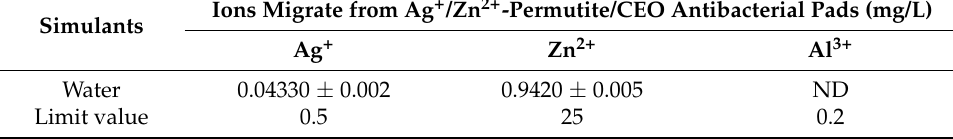
Table 4. The total specific migration limits (SML/T) of Ag + /Zn 2+ -permutite/ceo pads.